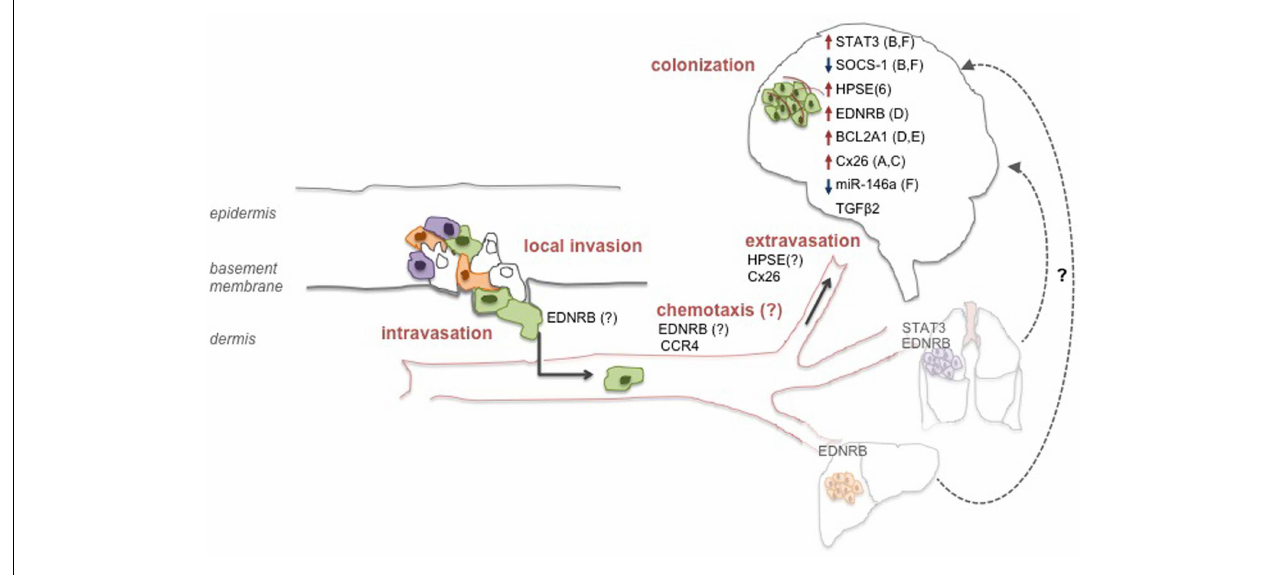
FIGURE 1 | Molecular determinants of melanoma brain metastasis . Molecular alterations may occur on all consecutive steps that support the metastatic process of melanoma cells to the brain. Alterations in specific factors may support processes at the primary tumor site and endow a subset of cells with the ability to reach the brain (represented by green cells). Other factors may direct migration to the brain via chemotaxis, or promote adhesion and extravasation through the